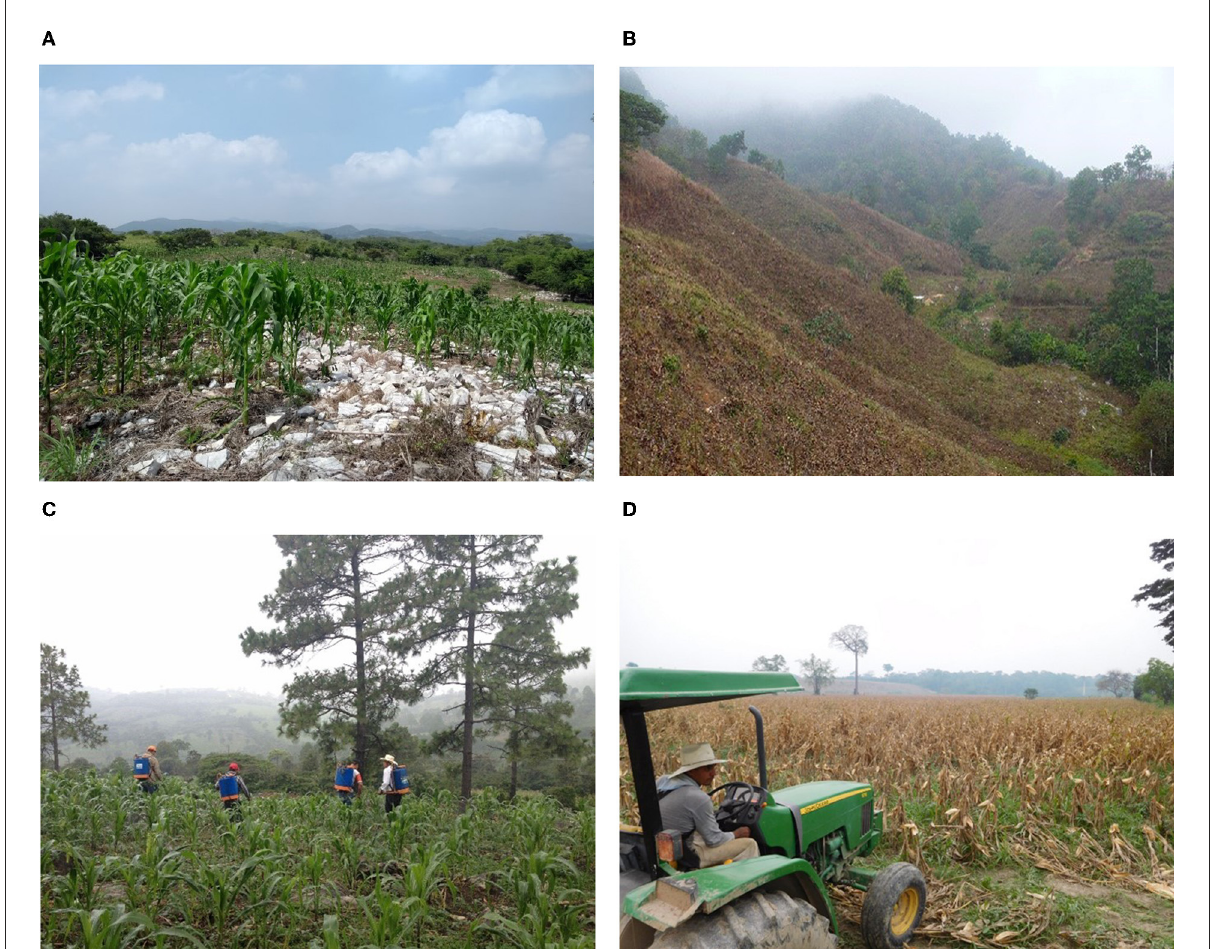
FIGURE2 Fields and maize crops in four regions. (A) The VO region, plot in rocky soil; (B) the SV region, plot after the maize harvest; (C) the AV region, plot with a variety of criollo maize and herbicide application by the family; (D) The MC region, plot with mechanization in the maize harvest. Credits: (A) Sofia Monroy; (B) Riccardo Pavesi; (C) Daniel Mascorro; and (D) Carolina